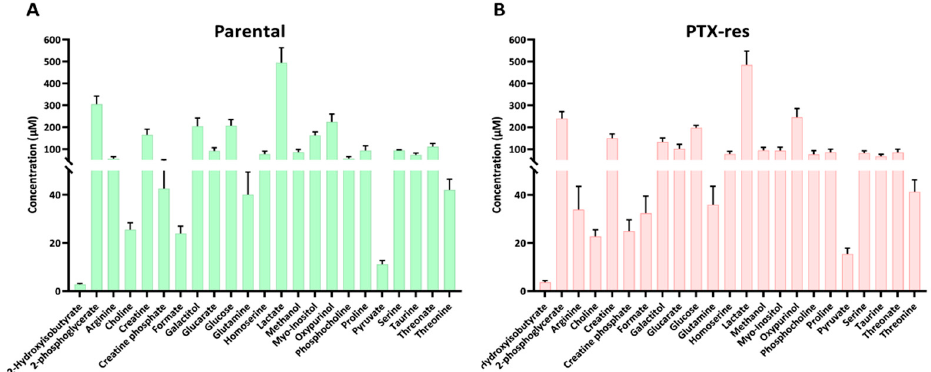
Figure 4. Quantification of metabolites extracted from the SUM159 parental and PTX-res cells . Extraction of metabolites using a two-phase process and metabolite quantification using the Chenomx software were conducted. Twenty-three metabolites were detected in both cell lines with high confidence. ( A ) The concentrations of the 23 metabolites in parental cells ranged from 28 ± 0.38 to 495 ± 67 µ M. ( B ) The concentrations of the 23 metabolites in the PTX-res cells ranged from 3.6 ± 0.78 to 485 ± 63 µ M. Error bars indicate the SEM of biological replicates (n = 6). Nonetheless, several metabolites (arginine, creatine phosphate, myo-inositol and